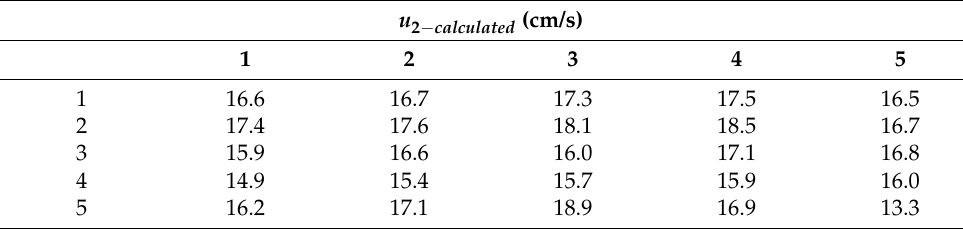
Table 3. Velocity component u 2 − calculated from the continuity equation.